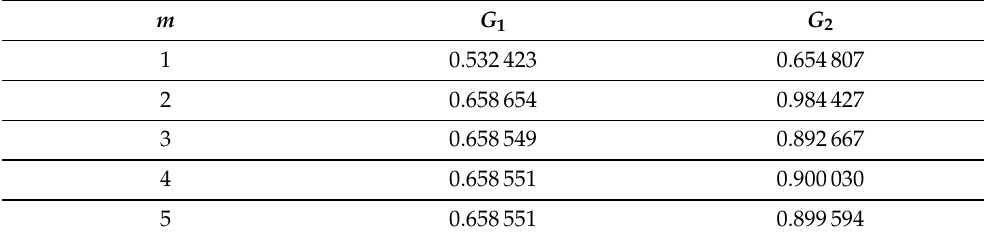
Table 2. Solutions of equation d 5 ( µ , ν , G ) = 0 for growing values of m ; µ = 1, ν = 1.